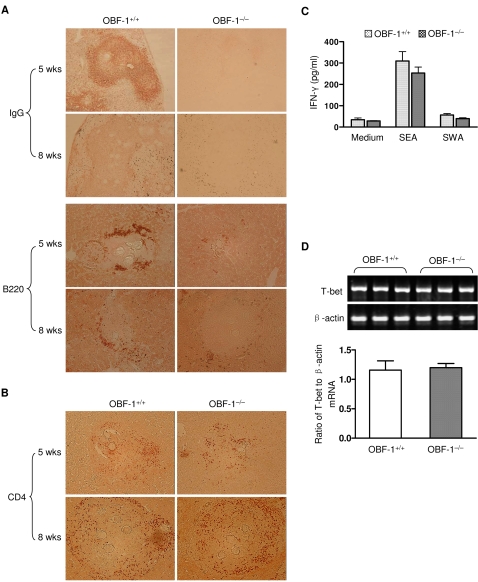
Defective granuloma pathology in OBF-1-null mice is associated with an altered accumulation of IgG and B220+ cells but not changes in the CD4+ or Th1 cell responses.(A) IgG deposition and B cell accumulation in the liver granulomas of OBF-1 wild-type and null mice was assayed at 5 or 8 weeks post-infection by immunohistochemical staining. Six or seven mice of each genotype were analyzed, and representative images are shown. Magnification: IgG (upper): 100×; B200 (lower): 200×. (B) CD4+ cell accumulation in liver granulomas was analyzed in six mice for each experimental condition. Representative images are shown. Magnification: 200×. (C) Splenocytes from 5 week post-infection mice were cultured with or without SEA or SWA for 7 days. Supernatants were collected, and the concentration of IFN-γ was determined by ELISA. Bars show the mean±SD of four mice for each genotype. (D) The mRNA expression of T-bet in splenic cells was measured by RT-PCR (upper). β-actin was used as an internal control. Relative T-bet mRNA levels are presented as a mean±SD (lower).